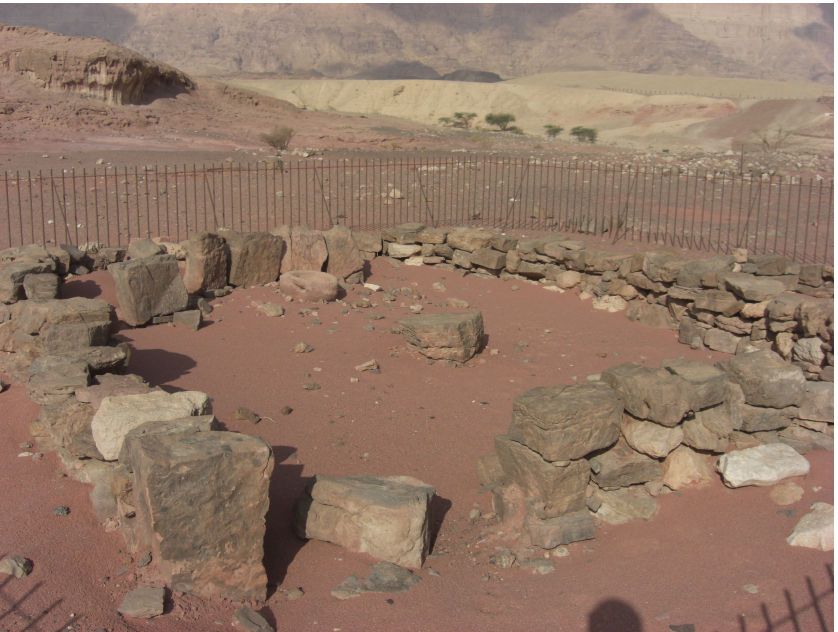
Figure 2 Consecutive open courtyard shrines at Timna Valley Site 2. View of the earlier shrine from the southeast, with altar at the center, and basin and row of standing stones in the back left corner. Photo by the author.